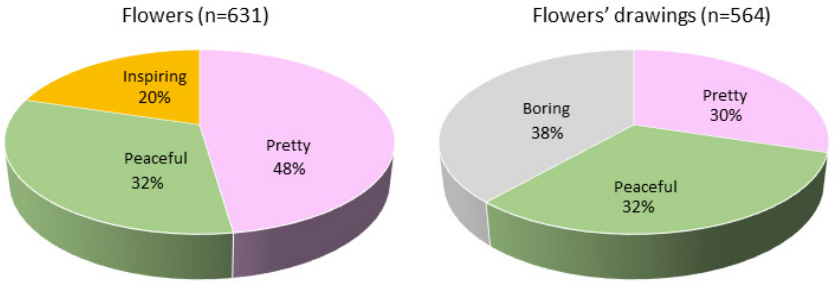
Figure 3. Occurrence (%) of the words most often chosen in relation to images of flowers and flow ‐ ers’